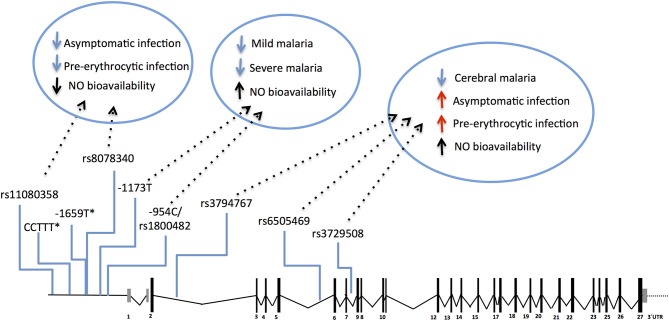
Genetic effects of NOS2 SNPs associated to malaria and nitric oxide bioavailability. The scaled diagram of NOS2 exon-intron structure depicts SNPs in the 5′region (rs11080358–rs1800482) and in the cistronic region (rs3794767–rs3729508) associated with malaria and with control of nitric oxide (NO) bioavailability. Genetic variants that decrease NO bioavailability in the 5′region have beneficial effects (blue arrows) in early stages of infection, possibly by favoring anti-parasite responses. In contrast, SNPs that increase NO bioavailability (mapping in the 5′ region or in the cistronic region) show an anti-inflammatory action favoring infection when parasite burden is low or when infection is unapparent (red arrows) but protect from mild malaria and increase resilience against severe malaria (blue arrows). (*) CCTTT and−1659 polymorphisms showed association with malaria severity and cerebral malaria but their role on NO bioavailability is not known. For allele description and reported genetic effects (Supplementary Table 1).